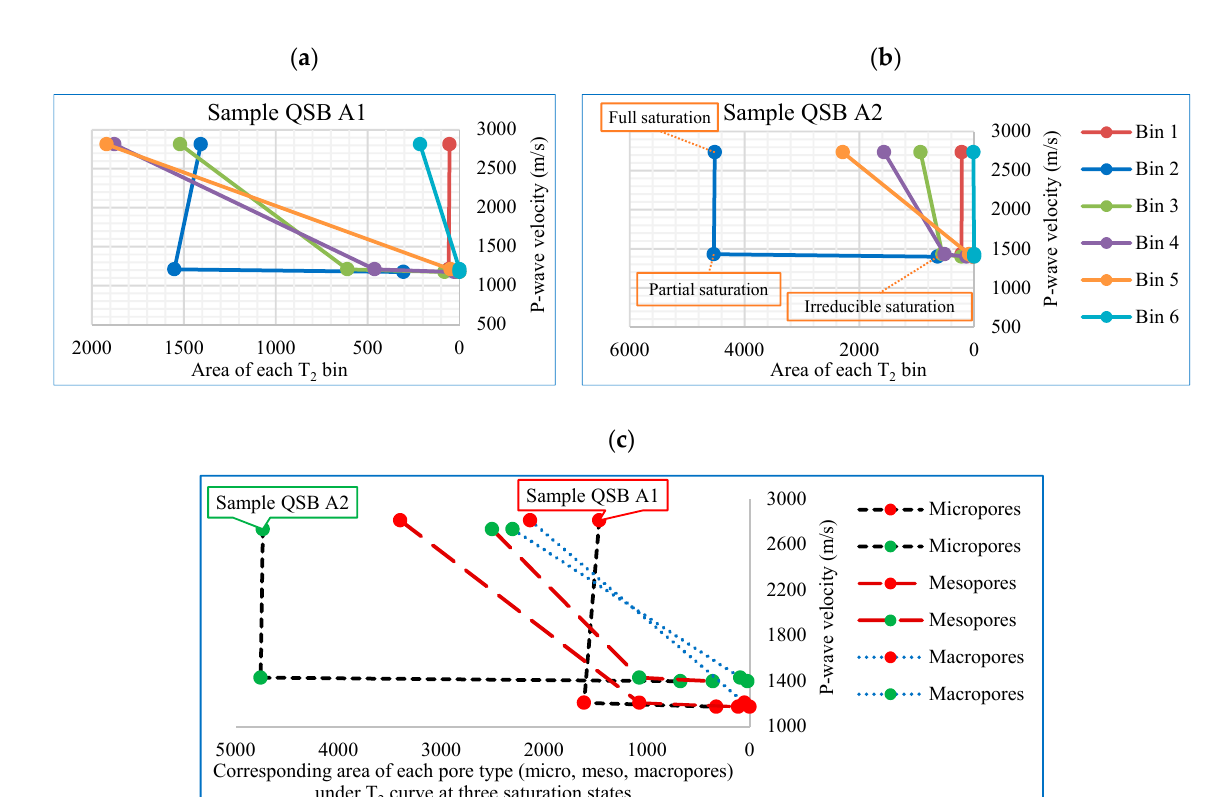
Figure 3. ( a , b ) Analyzing the contribution of each pore type (micro, meso, and macropores) to the decrease of elastic P-wave velocity for Sample QSB A1 and Sample QSB A2. The three data points on each graph represent the three saturation states, from left to right: full saturation, partial saturation, and irreducible saturation, respectively; ( c ) The green and red colors indicate the corresponding data points of the two samples. For each sample, there are three curves, which show the changes of microporosity (black dashed line), mesoporosity (dark red long-dashed line), and macroporosity (blue dotted line) of that sample at three saturation states, from left to right: full saturation, partial saturation, and irreducible saturation, respectively. The porosity value for each pore type at each saturation state was calculated by summing the values of bins 1–2 (for microporosity), bins 3–4 (for mesoporosity), and bins 5–6 (for macroporosity).